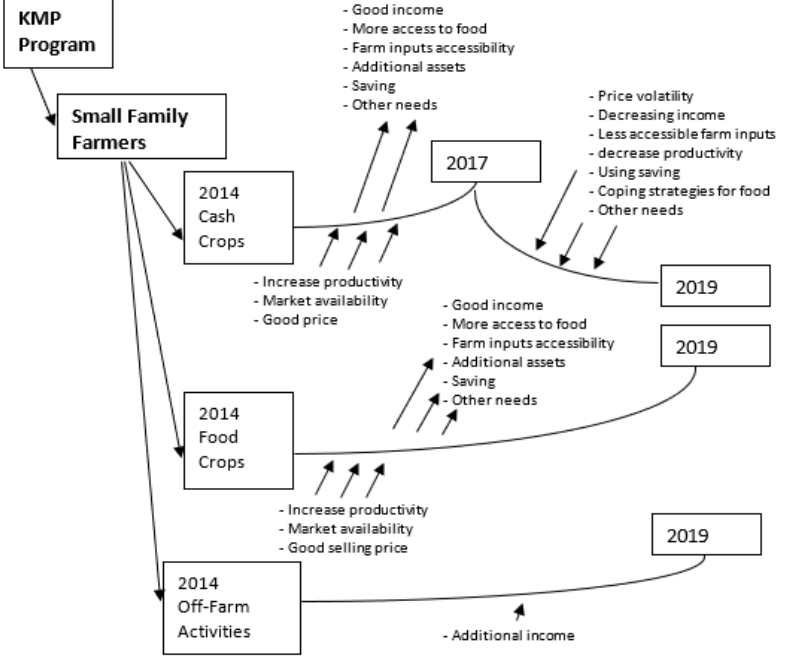
Figure 4. Changes in the income of farmers from 2014 to